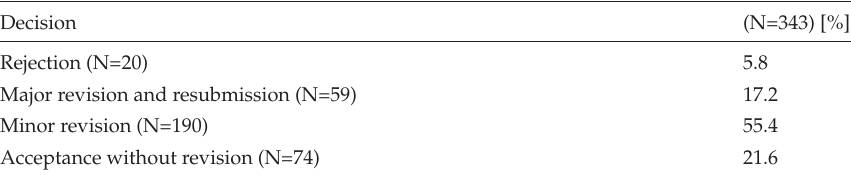
Table 3: Reviewers’ recommendations in the review reports [%].